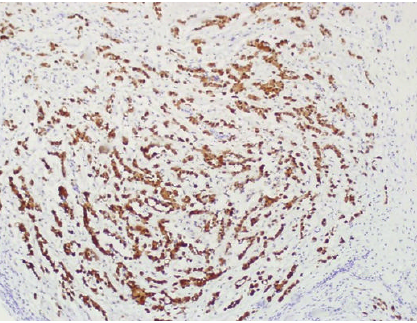
Figure 3: Immunohistochemistry showing calretinin-positive cells.